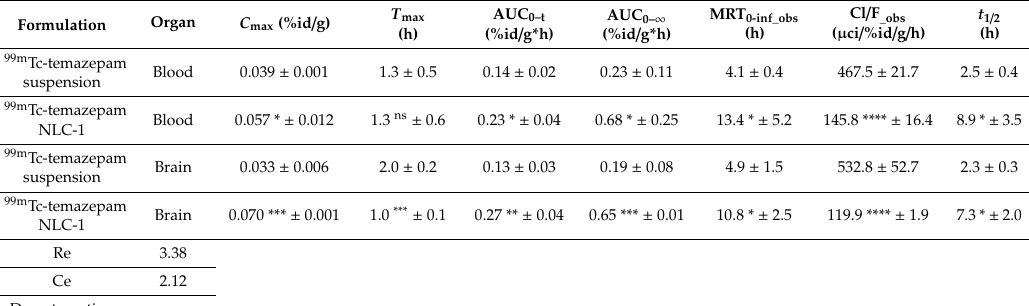
Table 6. Pharmacokinetic and targeting parameters in plasma and brain following oral